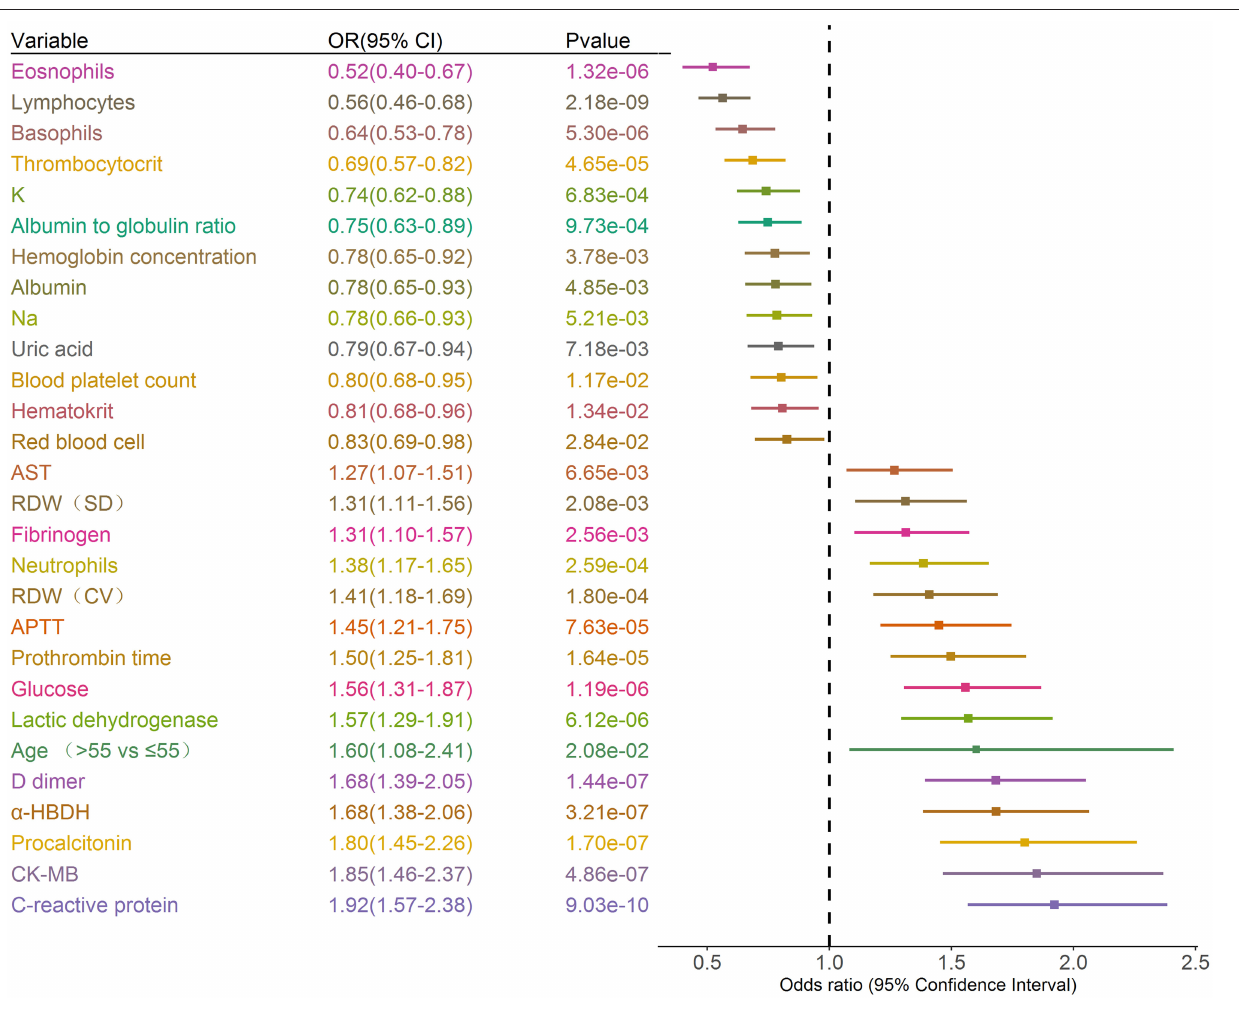
FIGURE 2 | Prognostic associations of clinical characteristics and laboratory findings in the development dataset. Unadjusted ORs (boxes) and corresponding 95% CIs (horizontal lines) for variables associated with the development of critical illness are represented. Box size is inversely proportional to the standard error of OR. The variables are stratified as quartiles. OR, odds ratio. CI, confidence